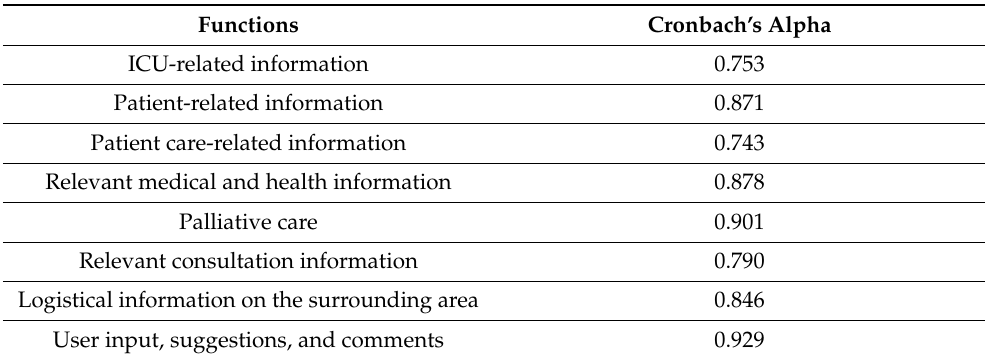
Table A4. Cronbach’s alpha of the ICU-SSS